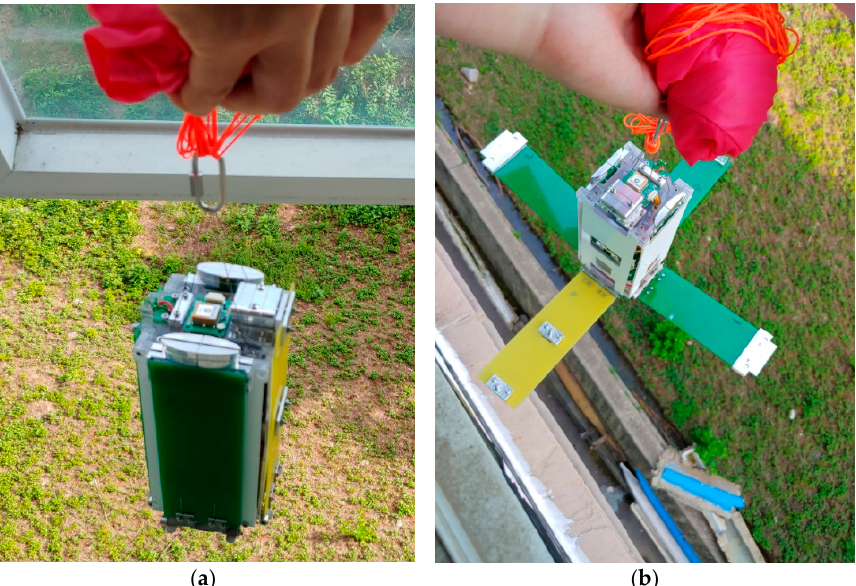
Figure 11. On-ground release function test setup of the mechanisms implemented in the DHRM CanSat flight model ( a ) before and ( b ) after deployment of the solar panels. Figure 12 shows the images captured by the onboard cameras of the CanSat in real time for the solar panel deployment status. The input voltage, separation signal, and ac- celeration response of each solar panel monitored during the on-ground release function tests of the mechanisms are shown in Figure 13. The results of the solar panel separation status and acceleration response during deployment indicate that all the panels were de- ployed within 0.89 s from the initiation of the burn wire triggering in the mechanism. The